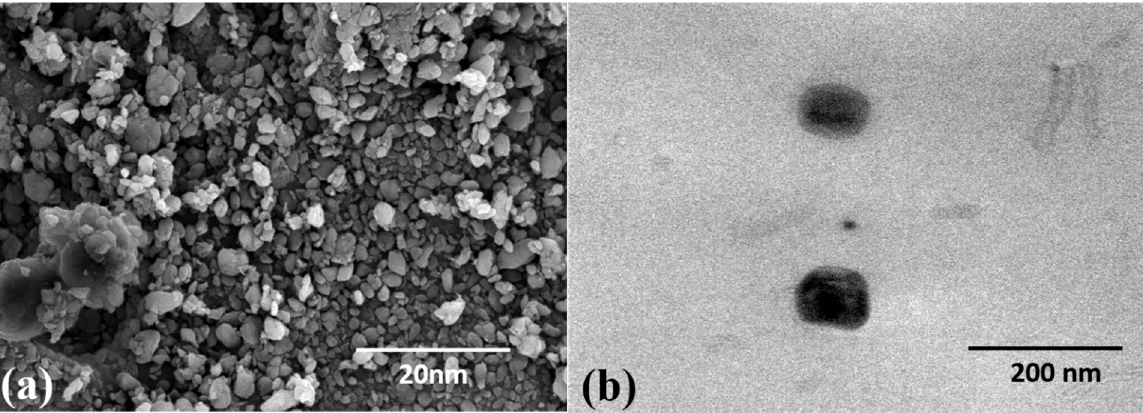
Figure 3. ( a ) SEM micrograph and ( b ) TEM micrograph of AgNPs synthesized using T. funiculosus culture filtrate.